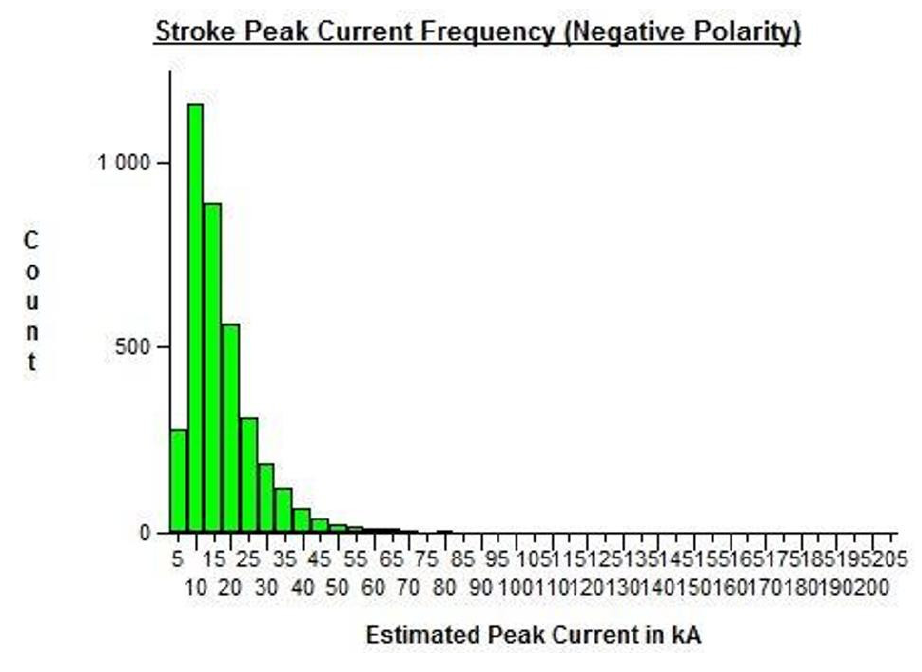
Figure 18. Stroke current frequency.